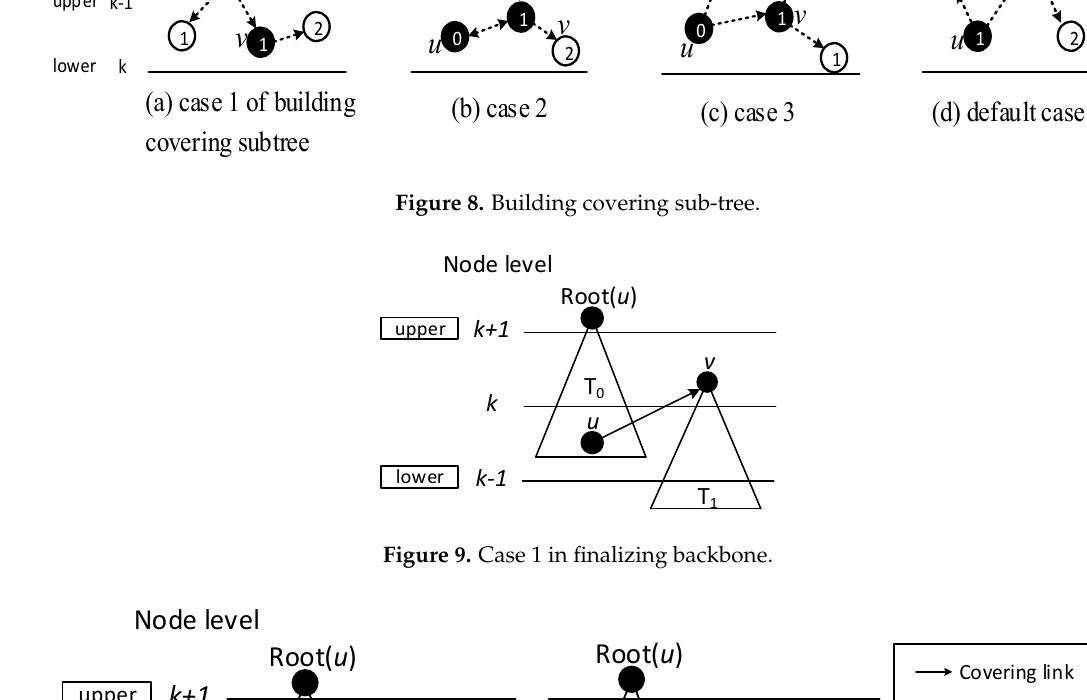
11 of 34 Figure 5. Original physical link . Figure 6. Level-clear figure with minimum for LBAS covering node set.